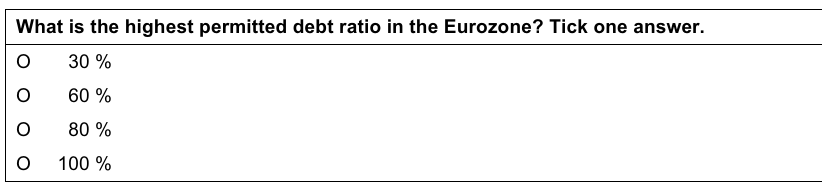
Fig. 2 Example of a forced-choice item on the Euro demand